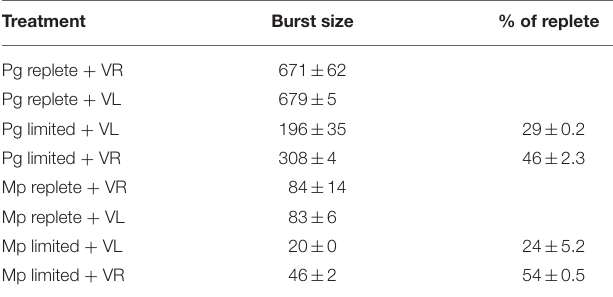
TABLE 3 | Burst sizes (number of virus progeny per lysed host cell) of PgV-07T and MpV-08T infecting Fe-replete and Fe-limited P. globosa (Pg) and M. pusilla (Mp),